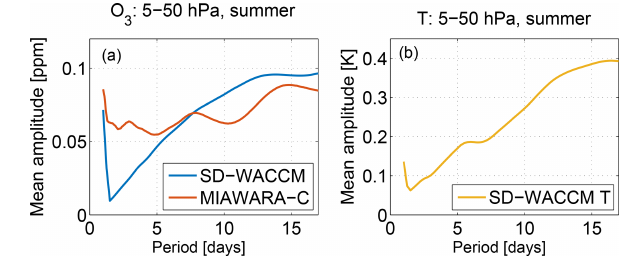
Figure 17. Mean amplitude for periods of 1–17d obtained by band- pass filtering the ozone time series (a) and the temperature time series (b) from GROMOS-C and SD-WACCM. The signal is av- eraged for 5–50hPa and for ± 40d around summer solstice of the years